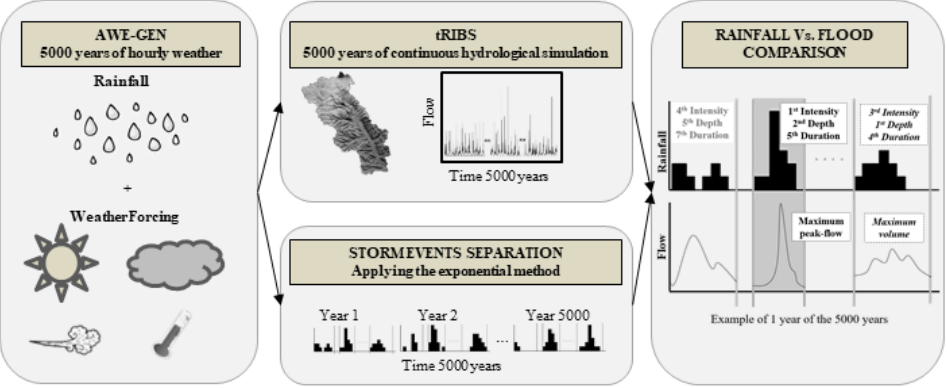
Figure 1. General scheme of the methodological approach.